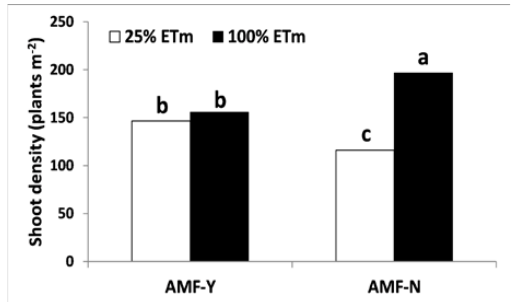
Figure 6. Effect of arbuscular mycorrhizal inoculation on shoot density under different water restitution levels. Different letters show statistical differences of the treatments at p < 0.01 (Least Significant Difference—Fisher test). AMF-Y = AMF-inoculated treatment; AMF-N = AMF uninoculated treatment; 25% ETm = restitution of crop evapotranspirated water at 25%; 100% ETm = restitution of crop evapotranspirated water at 100%.